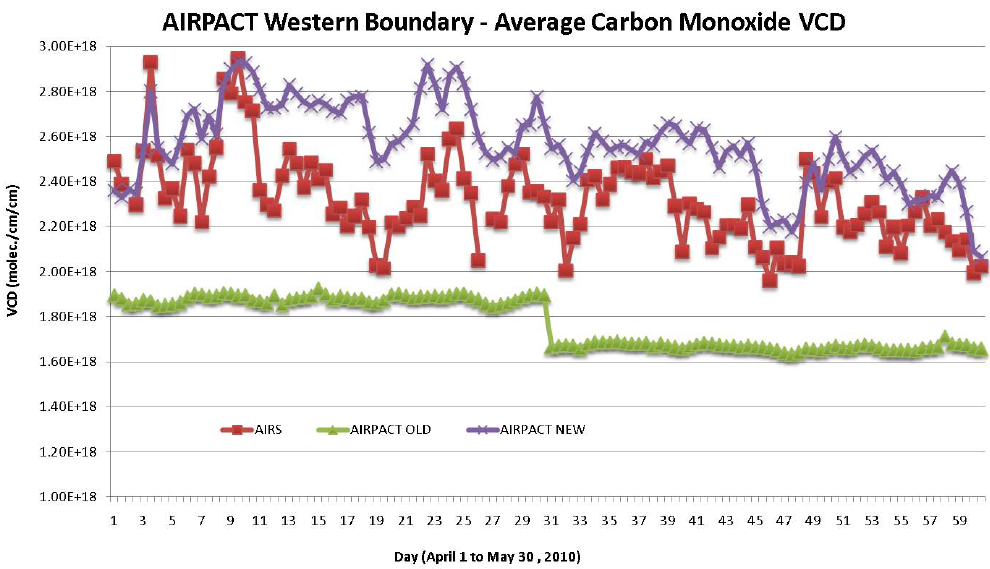
Fig. 3. The average CO VCD along AIRPACT’s western boundary during April and May of 2010 for ∼ 02:00 p.m. and ∼ 02:00 a.m. (PST).